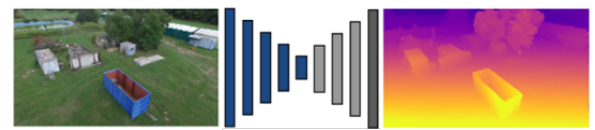
Figure 1. Schematic illustration of deep learning based monocu- lar depth